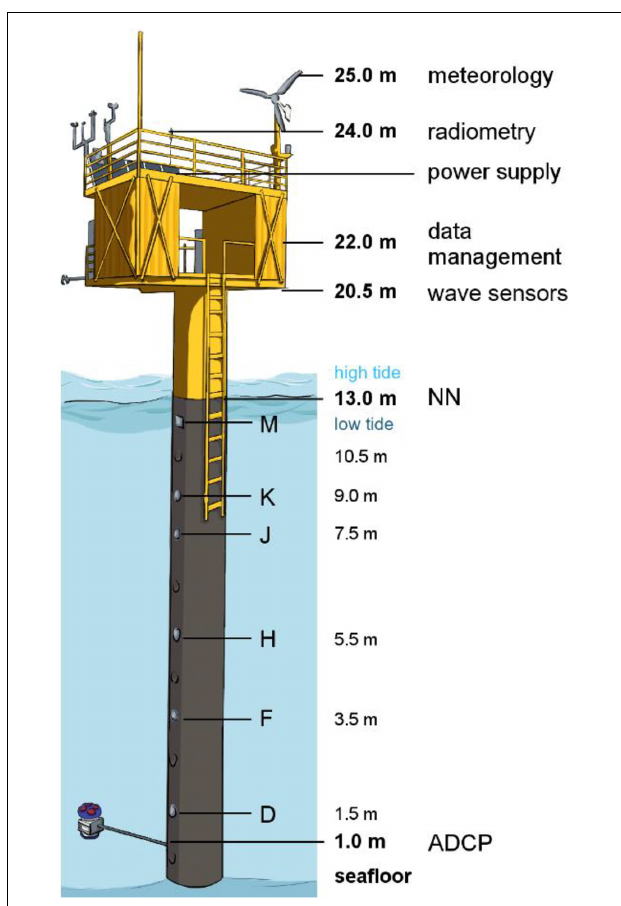
FIGURE 5 | Time-series station . Schematic figure of the Time-Series Station Spiekeroog. NN is defined at 13.0 m with slack water rising and sinking about 1.5 m. The waves may approach 20.5 m of height. The main body of the station contains the data management and batteries. The latter forms the power supply for the structure in combination with a solar panel and wind propulsion at 25 m. Sensors are applied to cylindrical tubes, which are deployed within the pole (M-D) below water. Tubes without depth markers remain closed while tubes with labels stay open enabling water to flow through with the sensors measuring designated parameters (D – temperature, conductivity, pressure | F, H, J – temperature, conductivity | K – temperature, conductivity, nutrients | M – oxygen, turbidity). The widget at level M is an additional sensor installed at the outside of the pole. At 1.0 m above the seafloor, an Acoustic Doppler Current Profiler (ADCP) is mounted perpendicular to the pole via a